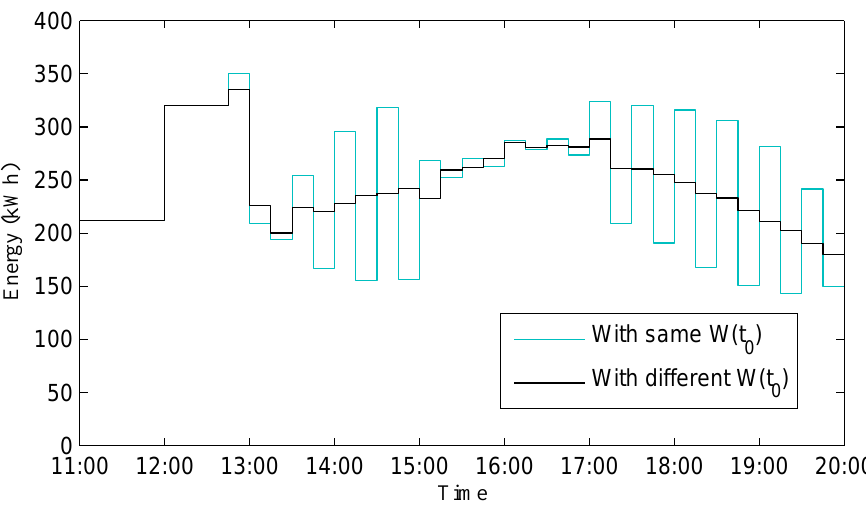
Figure 8. One hundred TCLs with the same W ( t k ) vs. 100 TCLs with different W ( t k ) .